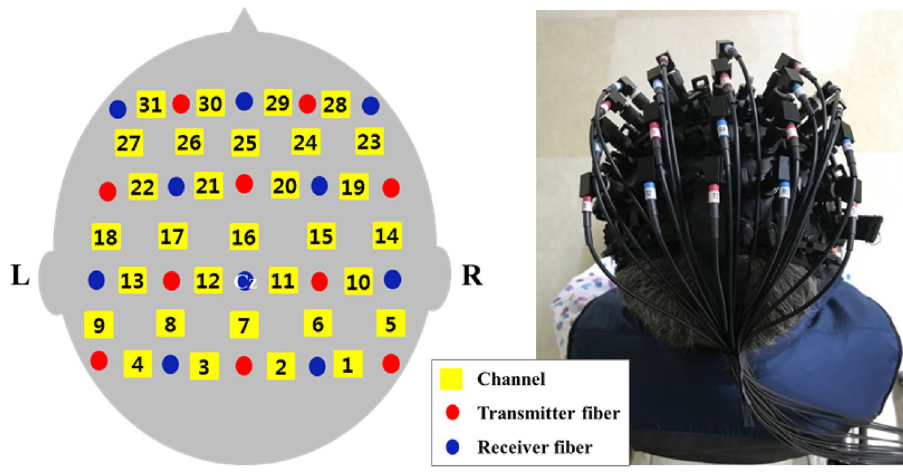
Figure 2. The placement of channels and probes for functional near-infrared